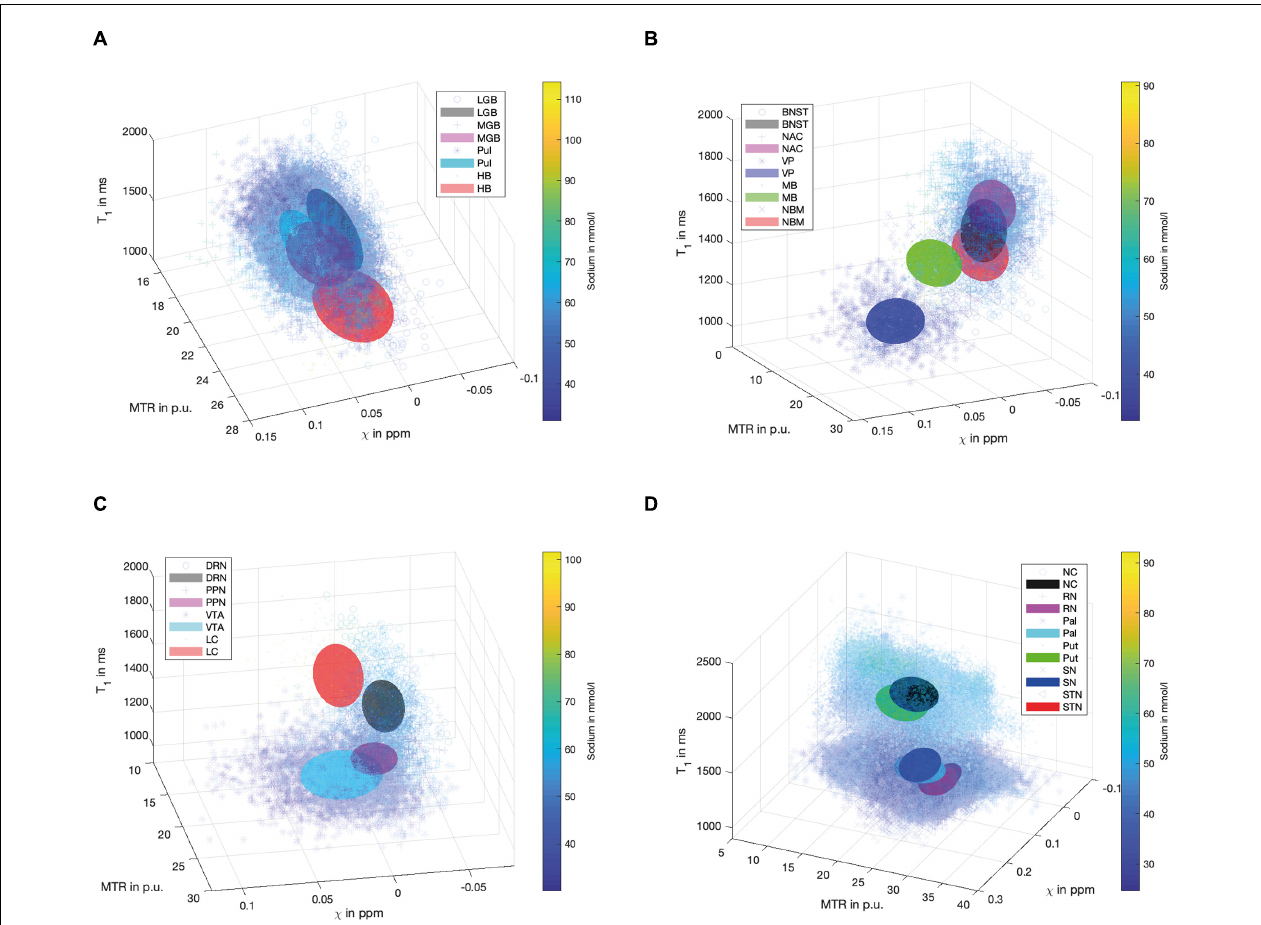
FIGURE 4 | Scatter plots for the group of (epi-)thalamic nuclei (A) with the LGB (black), the MGB (magenta), the PUL (cyan) and the HB (red), the limbic nuclei (B) with the BNST (black), NAC (magenta), VP (blue), MB (green) and the NBM (red), the ARAS (C) with the DRN (black), PPN (magenta), VTA (cyan), and LC (red) and the extrapyramidal nuclei (D) with the NC (black), RN (magenta), PAL (cyan), PUT (green), SN (blue), and STN (red) are shown. Tri-axial ellipsoids are centered at the mean signal intensity of a subcortical nucleus in each imaging contrast and axial lengths of the ellipsoids correspond to the standard deviation in each contrast. Markers and colors of ellipsoids represent each structure according to the legends of (A–D) . Each marker is colored according to the voxel-wise sodium